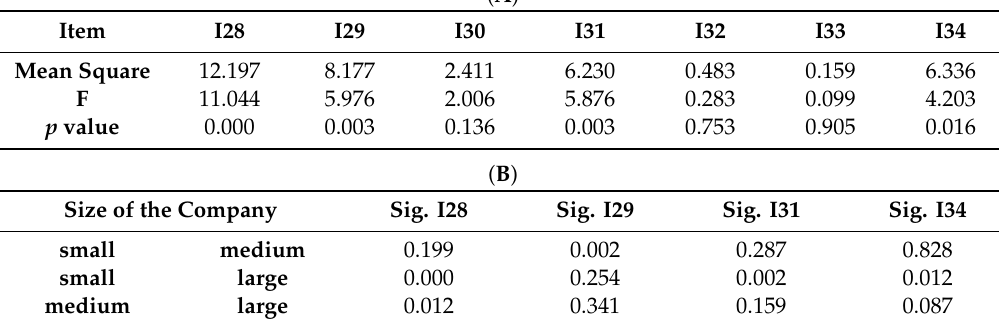
Table 12. ( A ) Significant di ff erences in talent development according to size of the company